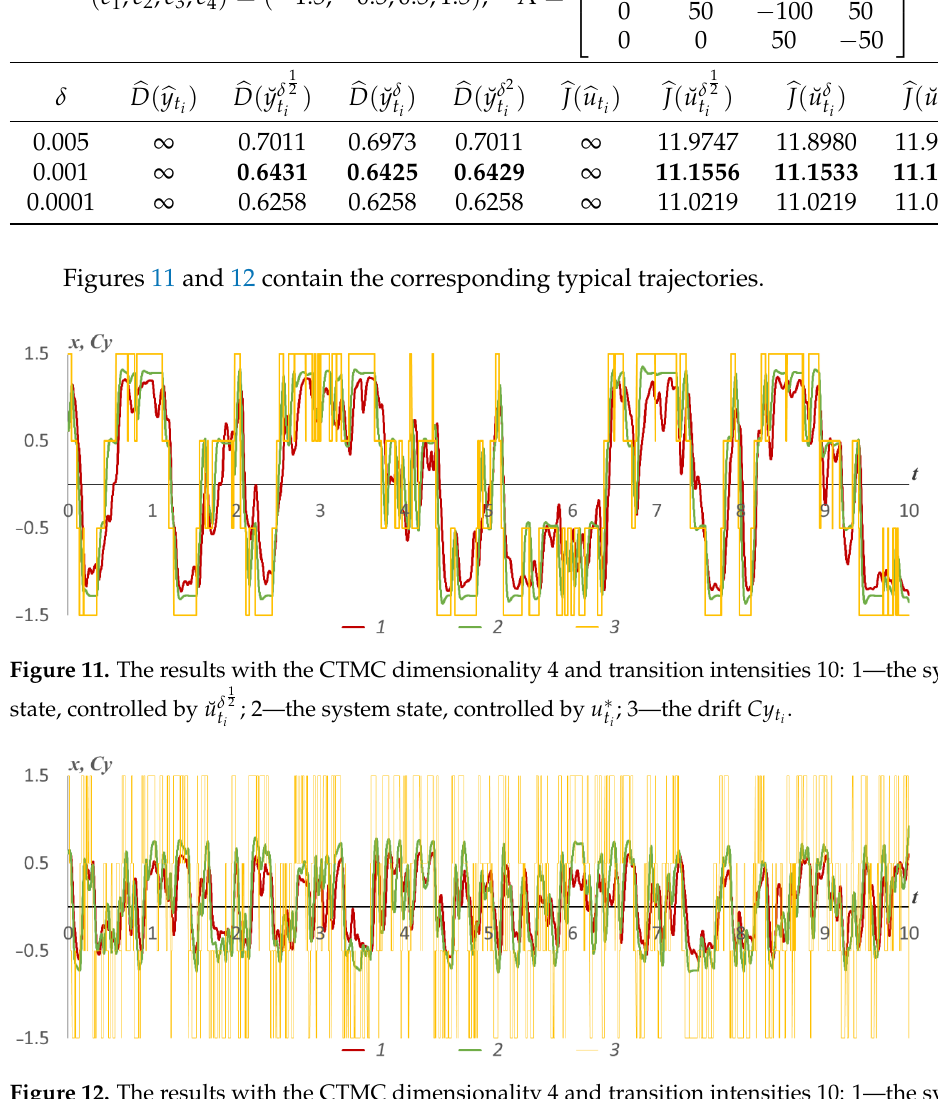
1 2 ; 2—the system state, controlled by u ∗ t t i